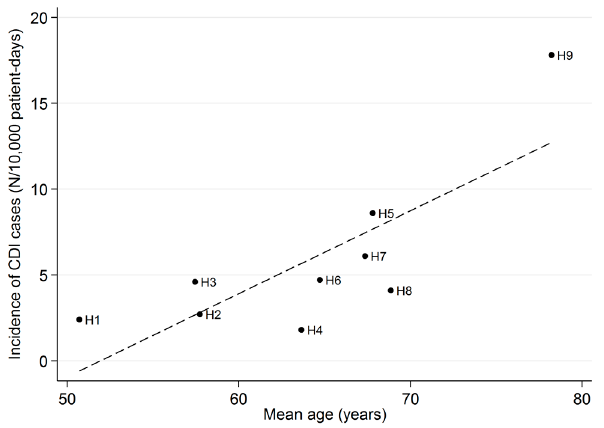
Figure 1. Overall incidences of CDI in the nine hospitals in relation to the mean age of the hospitalized patients.